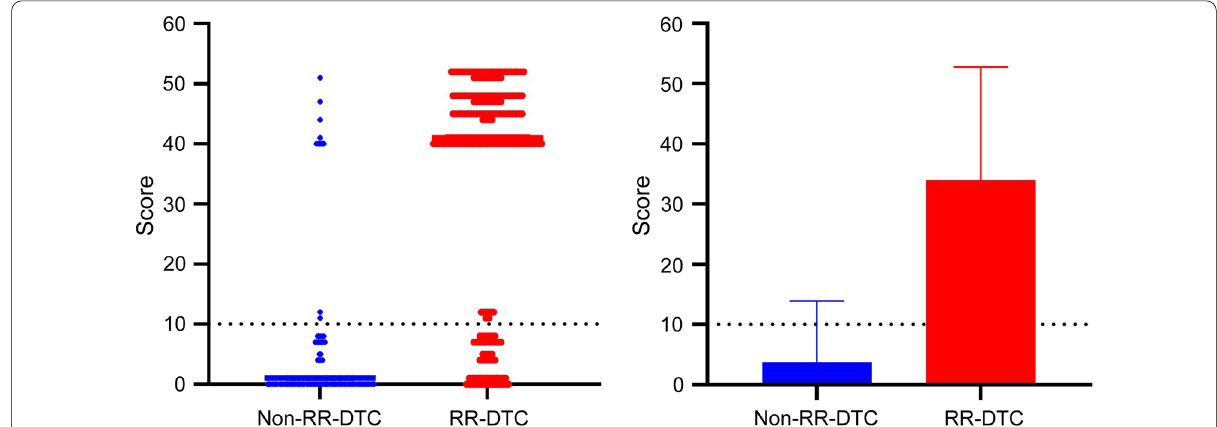
Fig. 4 Scatter diagram of the fractional distribution in the RR-DTC and non-RR-DTC groups. The division into the groups was made according to the scoring system. There were significant differences in scores between the two groups ( P < 0.001). ROC, receiver operating characteristic; RR-DTC, radioiodine refractory differentiated thyroid carcinoma; AUC, area under the